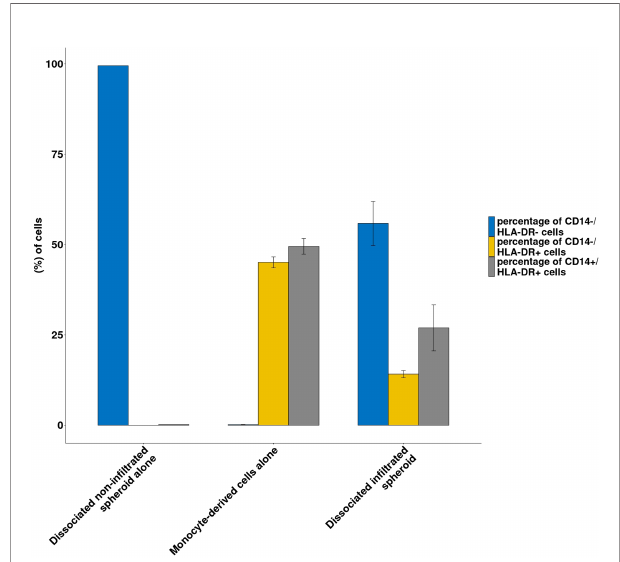
FIGURE 5 | Immune in fi ltration following co-culture between RCC spheroids and monocyte-derived cells. Histograms representing the proportion of CD14-/HLA-DR- cells (spheroid cells) or CD14+/HLA-DR + and CD14 - /HLA- DR + from the monocyte-derived population in the dissociated spheroid cultured alone or monocyte derived cells cultured alone or dissociated in fi ltrated spheroids are shown Results from a representative experiment; N=3; all conditions done in triplicate. Means ± SE are represented.